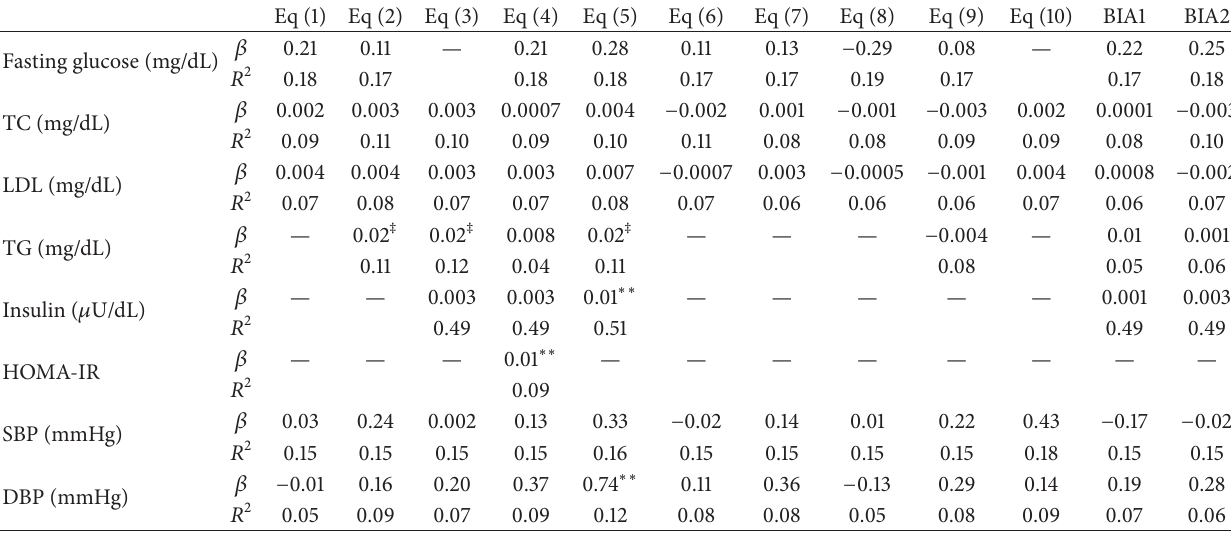
Table 4: Multiple linear regression coefficient ( 𝛽 ) and coefficient of determination ( 𝑅 2 ) of the relationship between percentage of body fat, adjusted for sex and normal individuals with excess body fat, and biochemical and clinical parameters in eutrophic adolescents (G1) (Vic¸osa, Minas Gerais, Brazil